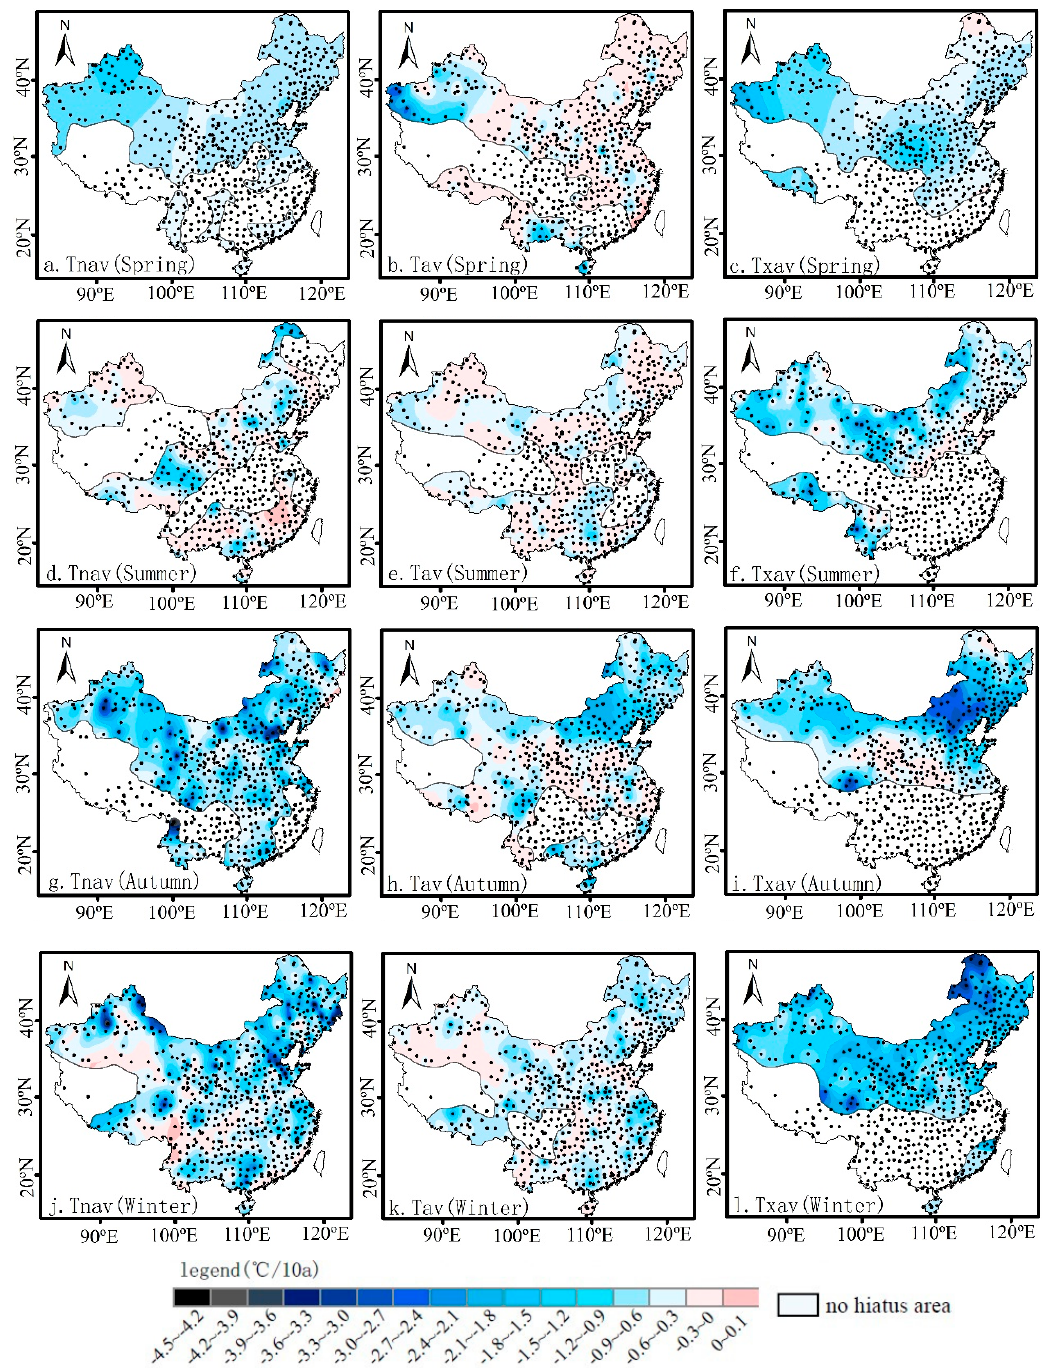
Figure 7. Spatial distribution of the tendency rates of the three temperature types in period T3 for each season of the study area.